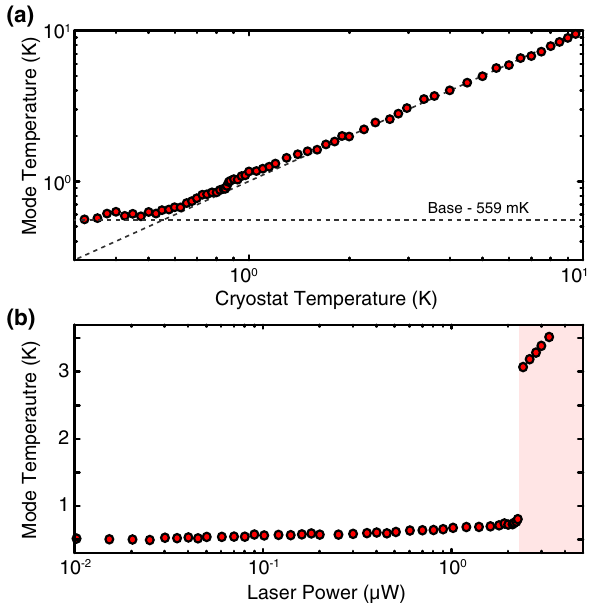
FIG. 3. (a) Mode temperature of the microtoroid flexural mode as the cryostat is cooled from 10 to 0.32 K. The microtoroid reaches a base temperature of 0.56 K with 100 nW of injected optical power. (b) Mode temperature of the flexural mode as the probe laser is increased from 10 nW to 3 . 3 μ W. Below 2 . 2 μ W the temperature increases slightly as the laser power is increased. Above 2 . 2 μ W the superfluid boils off, causing a sharp rise in mode temperature. red shaded region in Fig. 3(b). This threshold behavior